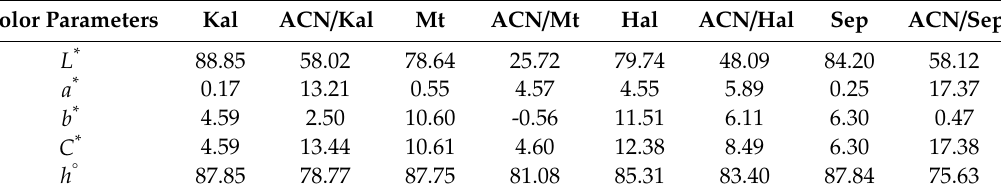
Table 2. Color parameters of the raw clay minerals and hybrid pigments.